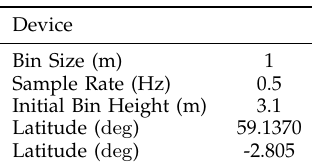
TABLE I D EVICE INFORMATION FROM THE RDI W ORKHORSE USED IN THE R E DAPT P ROJECT [11].